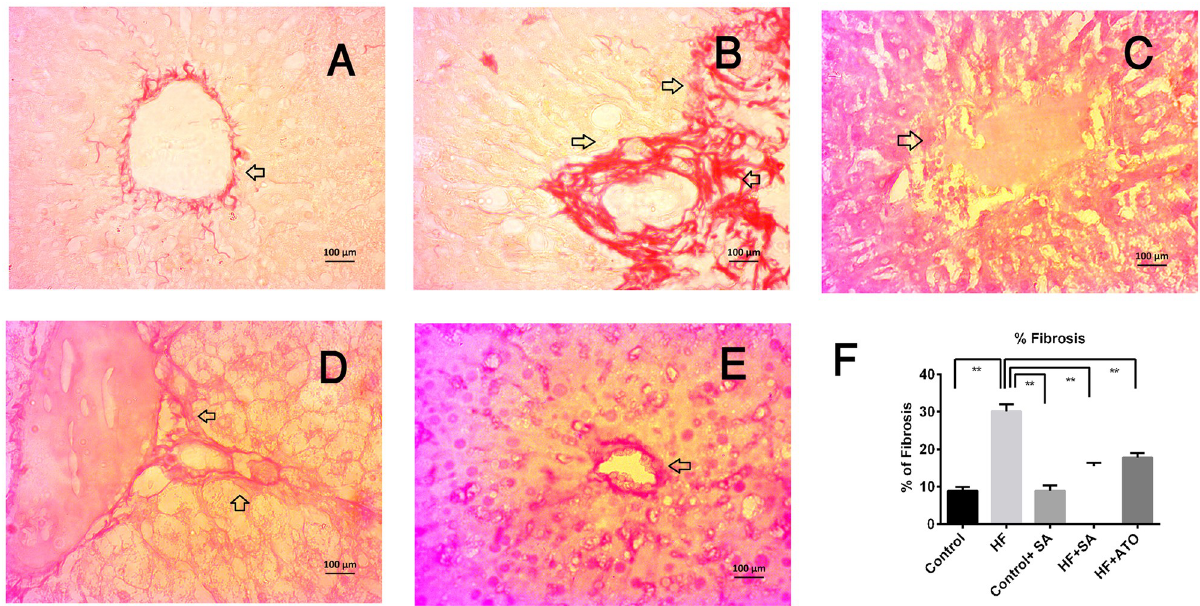
Fig 11. Effect of Senna alexandrina leaf powder supplementation on fibrosis in liver of high-fat diet-fed rats. A for control; B for HF; C for Control +SA; D for HF+SA; E for HF+ATO group and F for % Fibrosis. Magnifications 40X.